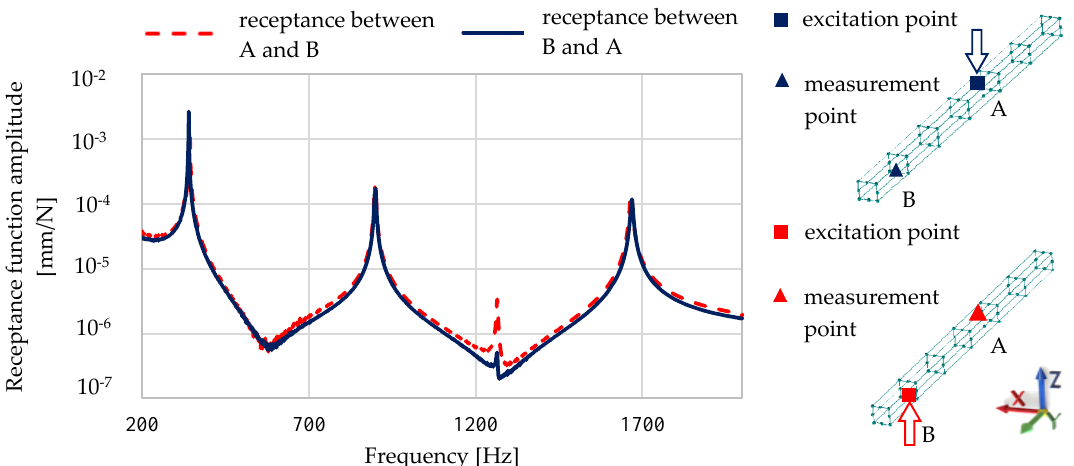
Figure 4. Comparison of the receptance functions determined to verify the Maxwell reciprocal theorem.